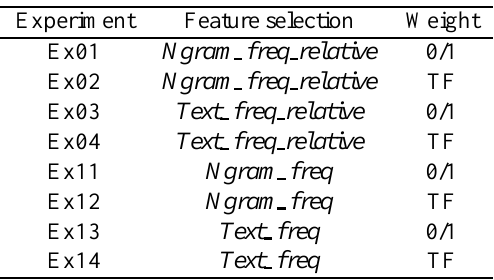
Table 3. Experiment scenarios